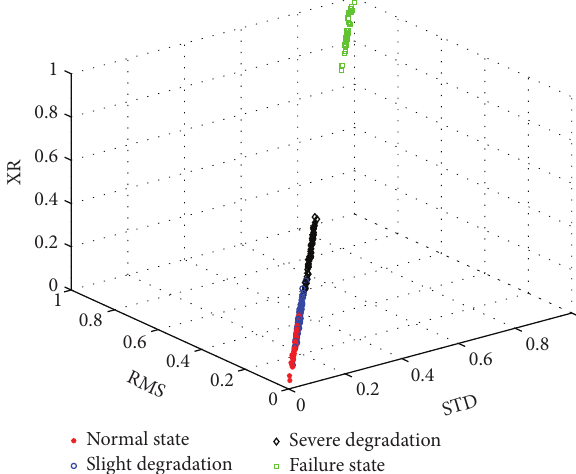
Figure 8: Space distribution of LPP fusion